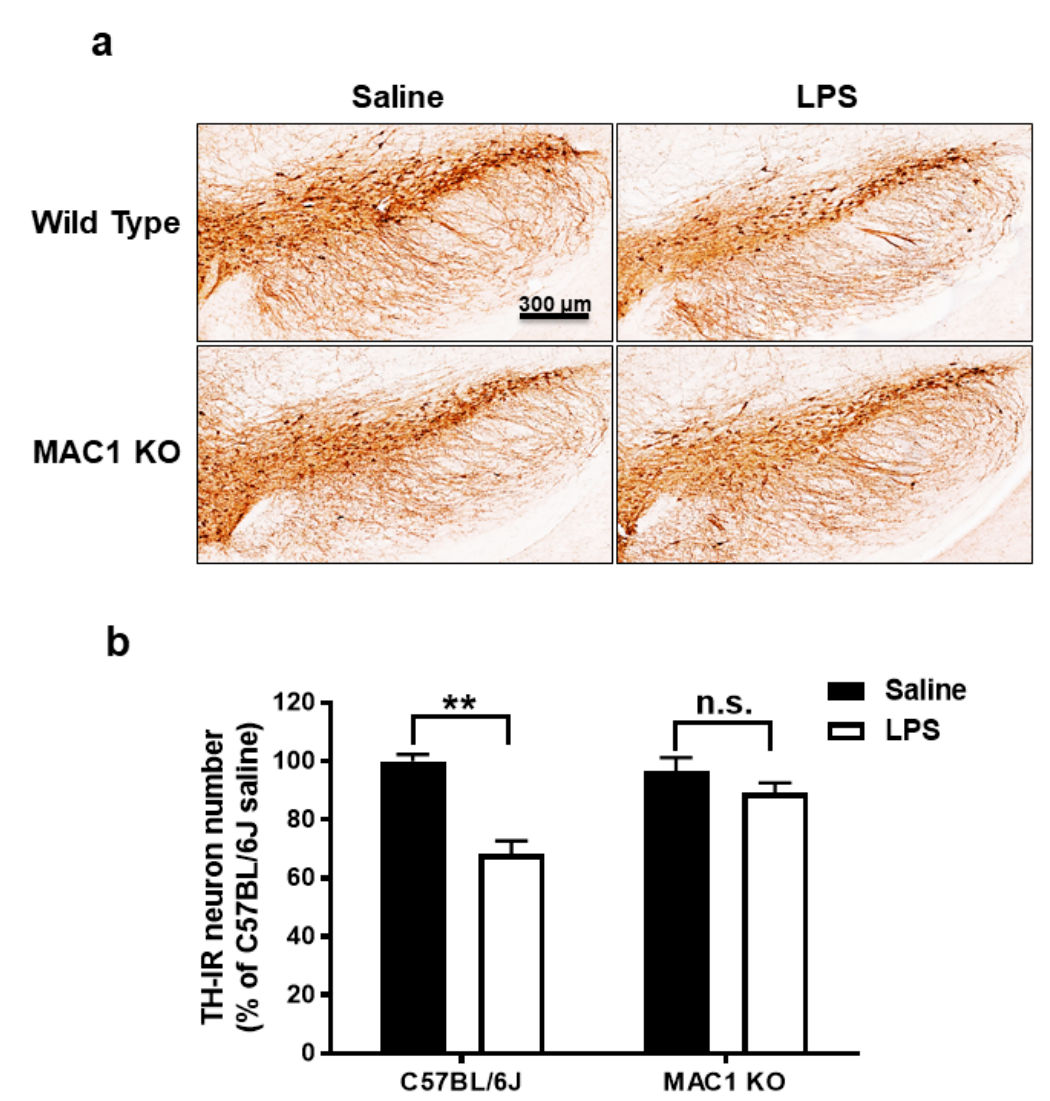
Figure 2. LPS-elicited loss of dopaminergic neurons was ameliorated in MAC1 KO mouse brains. ( a ) C57BL/6J and MAC1 KO mice were injected with saline or LPS for 12 months (WT control N = 3, WT LPS N = 5, MAC1 KO control N = 3, MAC1 KO LPS N = 5). Brains were removed for immunostaining with a DAergic neuron marker, tyrosine hydroxylase (TH). (N = 3) ( b ) Cell counting results. Scale bar = 300 µ m; ** p <